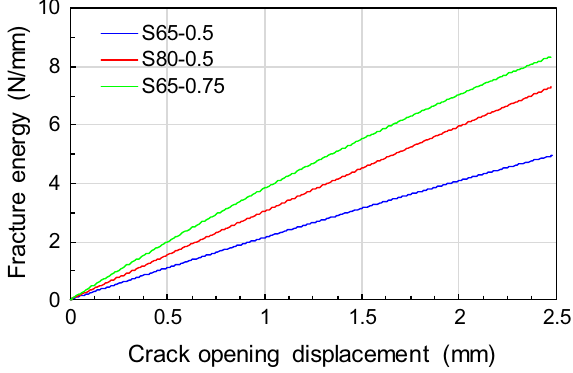
Fig. 10 Material modeling.